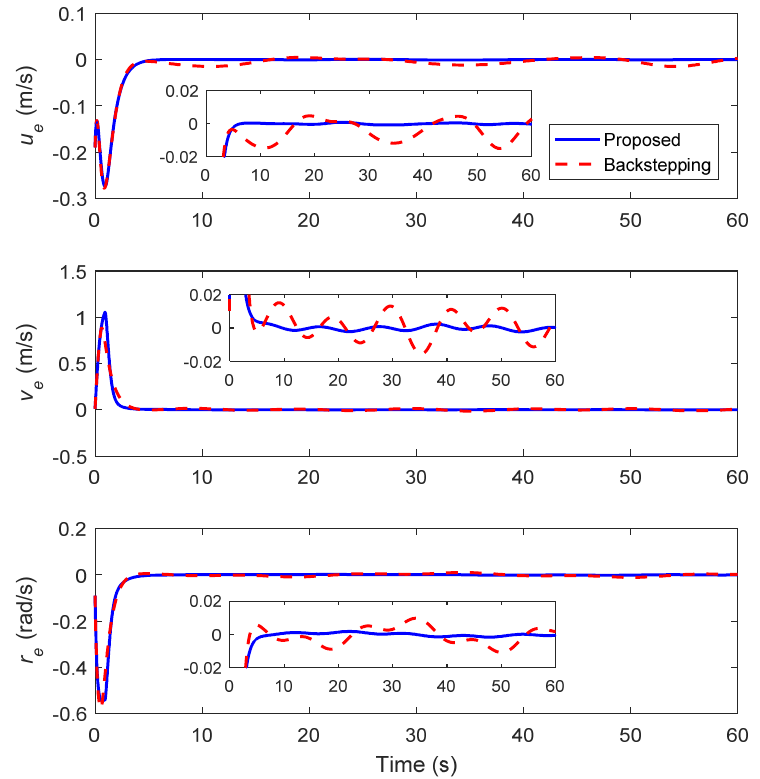
Figure 7. Profile of the velocity tracking errors (Case 1). Figure 7. Pro fi le of the velocity tracking errors (Case 1). Figure 7. Pro fi le of the velocity tracking errors (Case 1).